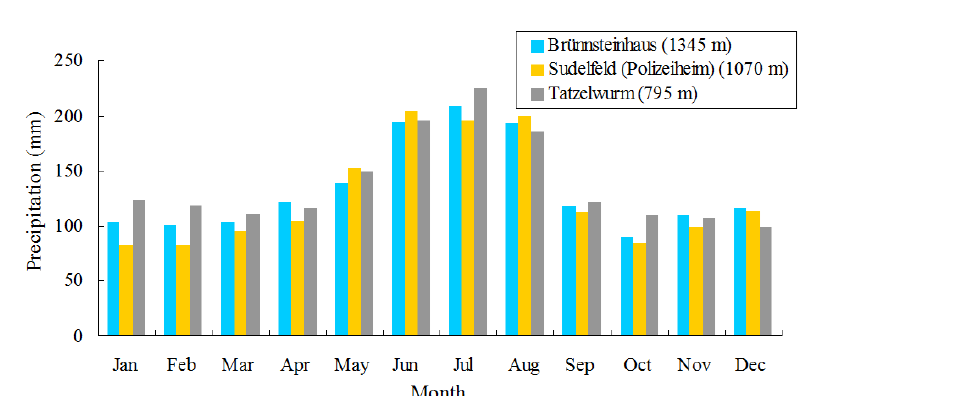
Figure 3. Geological profile of the Aggenalm landslide (Festl, 2014).